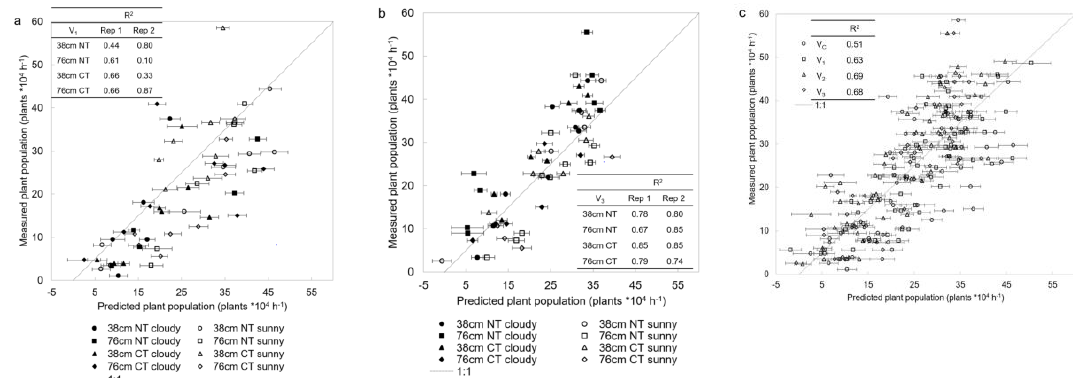
Figure 2. Plant population (plant × 10 4 h − 1 ) predicted by partial least squares regression (PLSR) vs. measured. Prediction of plant population for row spacing treatments, 38 and 76 cm, and till treatments NT (no till) and CT (conventional till) under sunny and cloudy conditions for validation dataset of V 1 (vegetative) development stage ( a ) and V 3 development stage ( b ). R 2 values for PLSR validated by replicate 1 (cloudy) and replicate 2 (sunny) for the row spacing and till treatments are presented as well. Prediction of plant population, for development stages V C , V 1 , V 2 , and V 3 by validation datasets including all treatments and both replicates together ( c ). R 2 values for PLSR validated by development stage. Error bars are the standard deviation of 100 cross validation iterations.